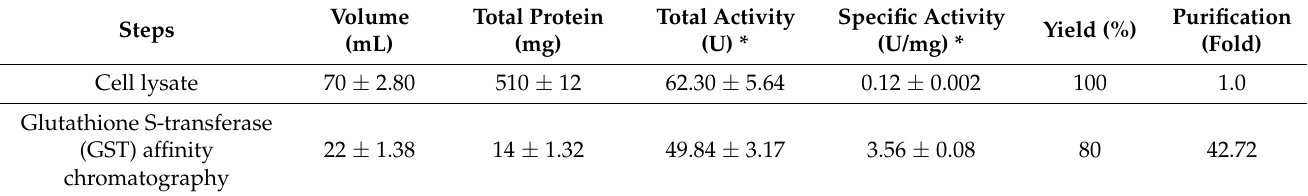
Table 2. Purification profile of MD2-SBro indicating its activity and yield.